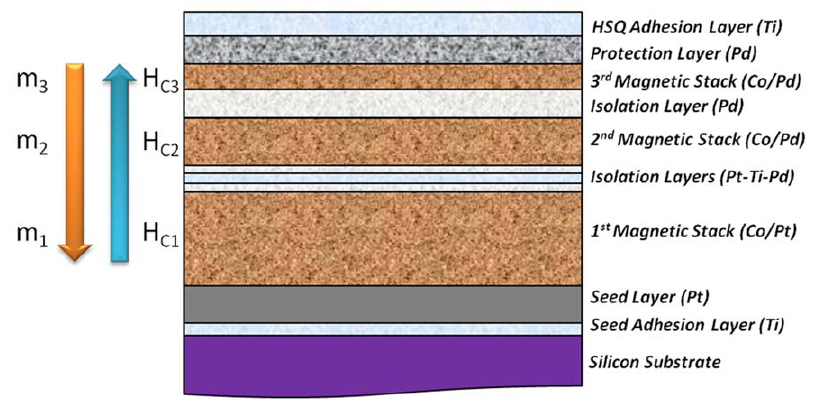
Figure 2. ML-3D magnetic media composition.